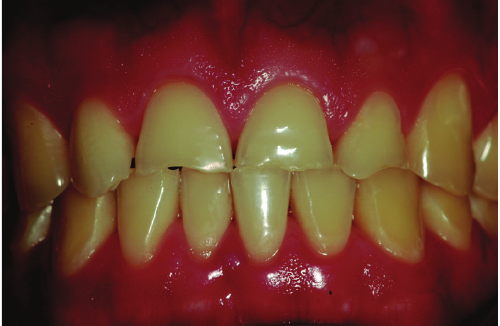
Figure 4: Mandibular arch view.